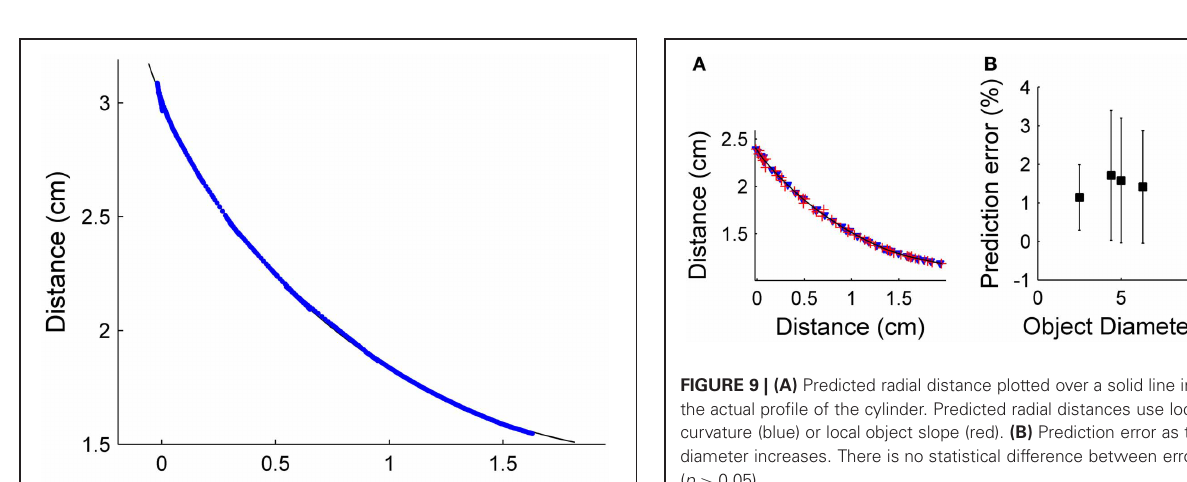
FIGURE 7 | Effect of vibrissal spacing. (A) Maximum curvature discriminable by a given whisker spacing. (B) Prediction of radial distance on different curvature scales with 1cm whisker spacing. The simulated object is shown in black, the starting positions of the vibrissae in blue, and the predicted contact points in red. The length of the spiral on the